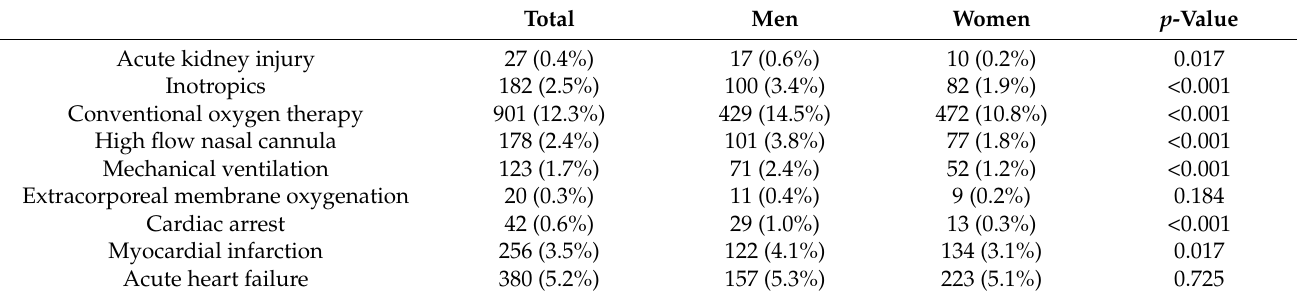
Table 3. Clinical outcomes according to